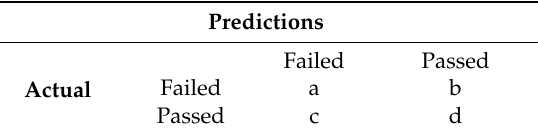
Table 2. Sample confusion